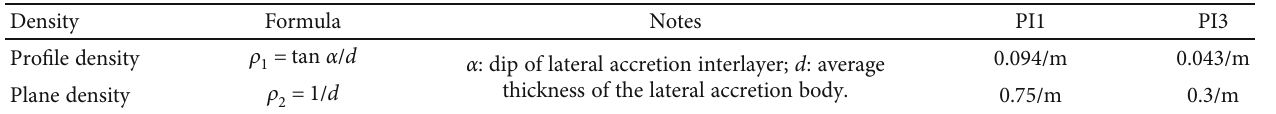
Table 4: Methods for calculating the interlayer